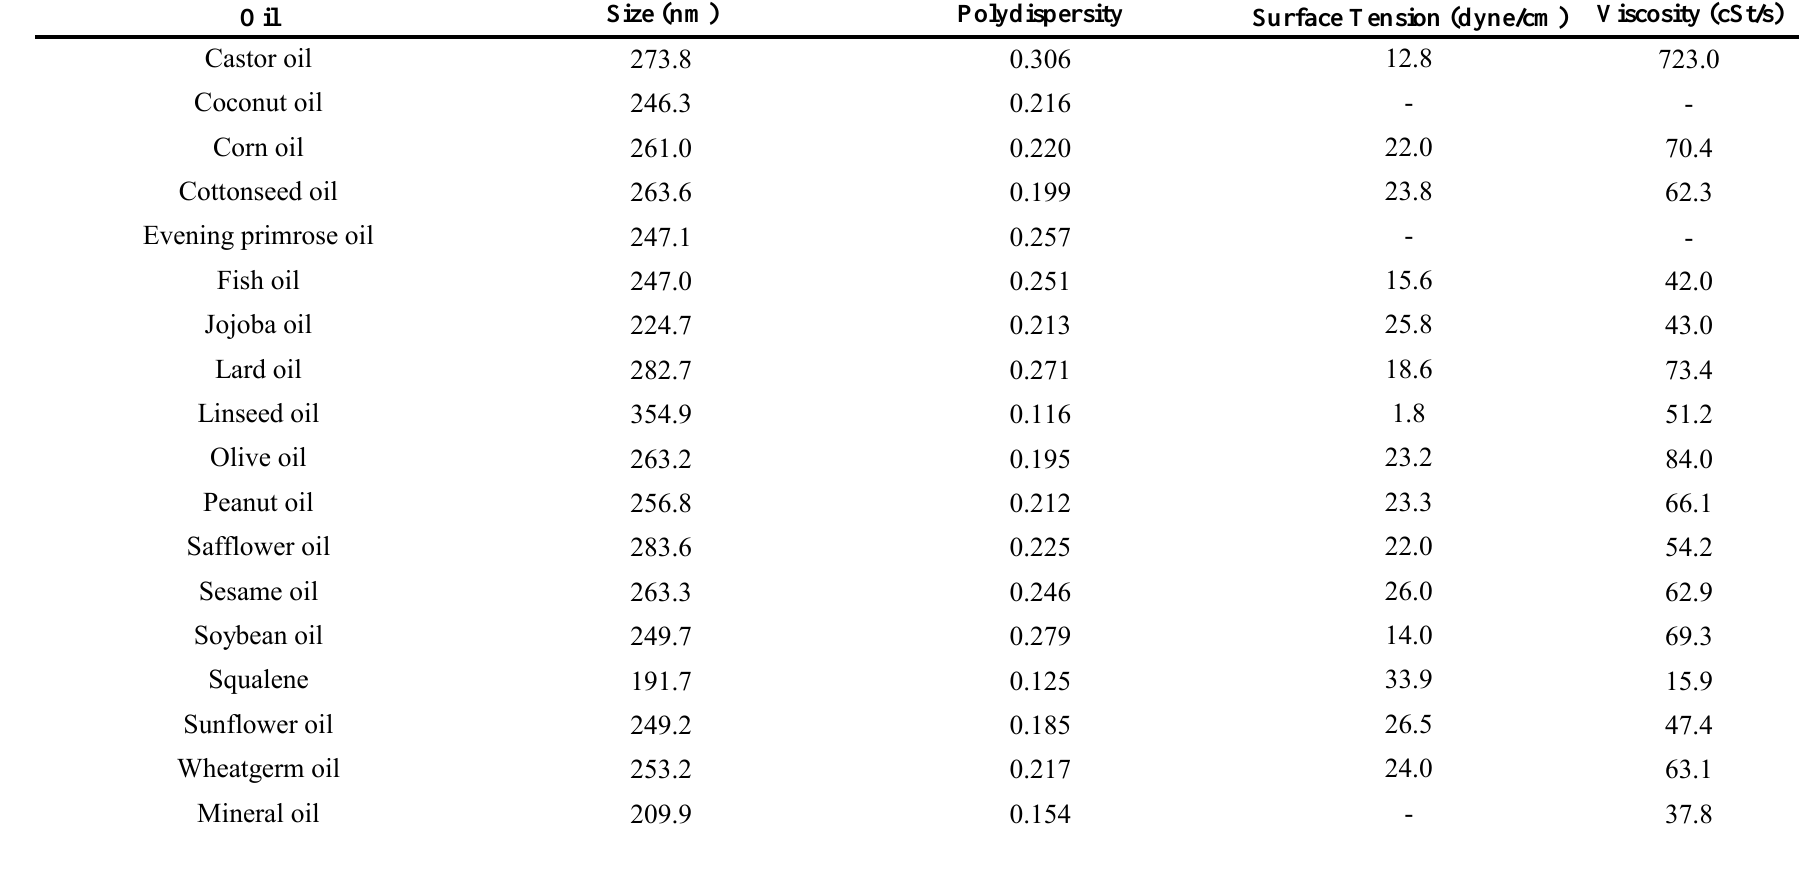
Table 1. Comparison of physicochemical properties of emulsions made with different oils, taken with permission from reference [3]. Surface tension and viscosity values were measured at 22 ± 2 °C and 20 ± 2 °C,